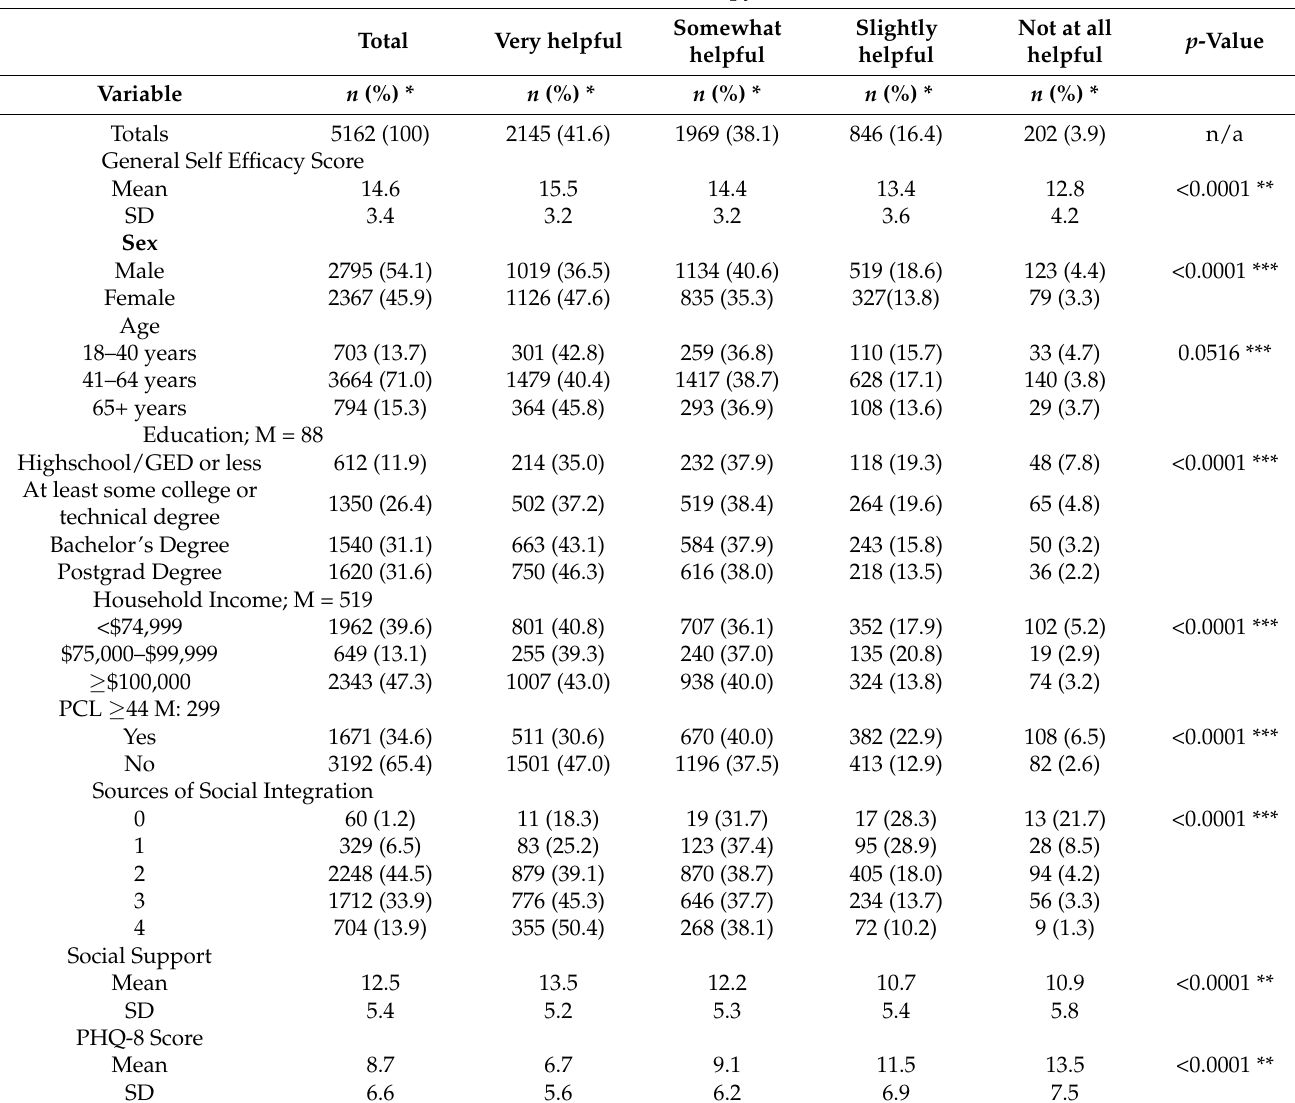
Table 5. Sociodemographic and Mental Health Characteristics of World Trade Center Health Registry Enrollees Who Had at Least One Session of Counselling or Therapy after 9/11, Stratified by Perception of Helpfulness of last Counseling or Therapy Appointment (i.e., Outcome #3), 2015 to 2016 ( n =